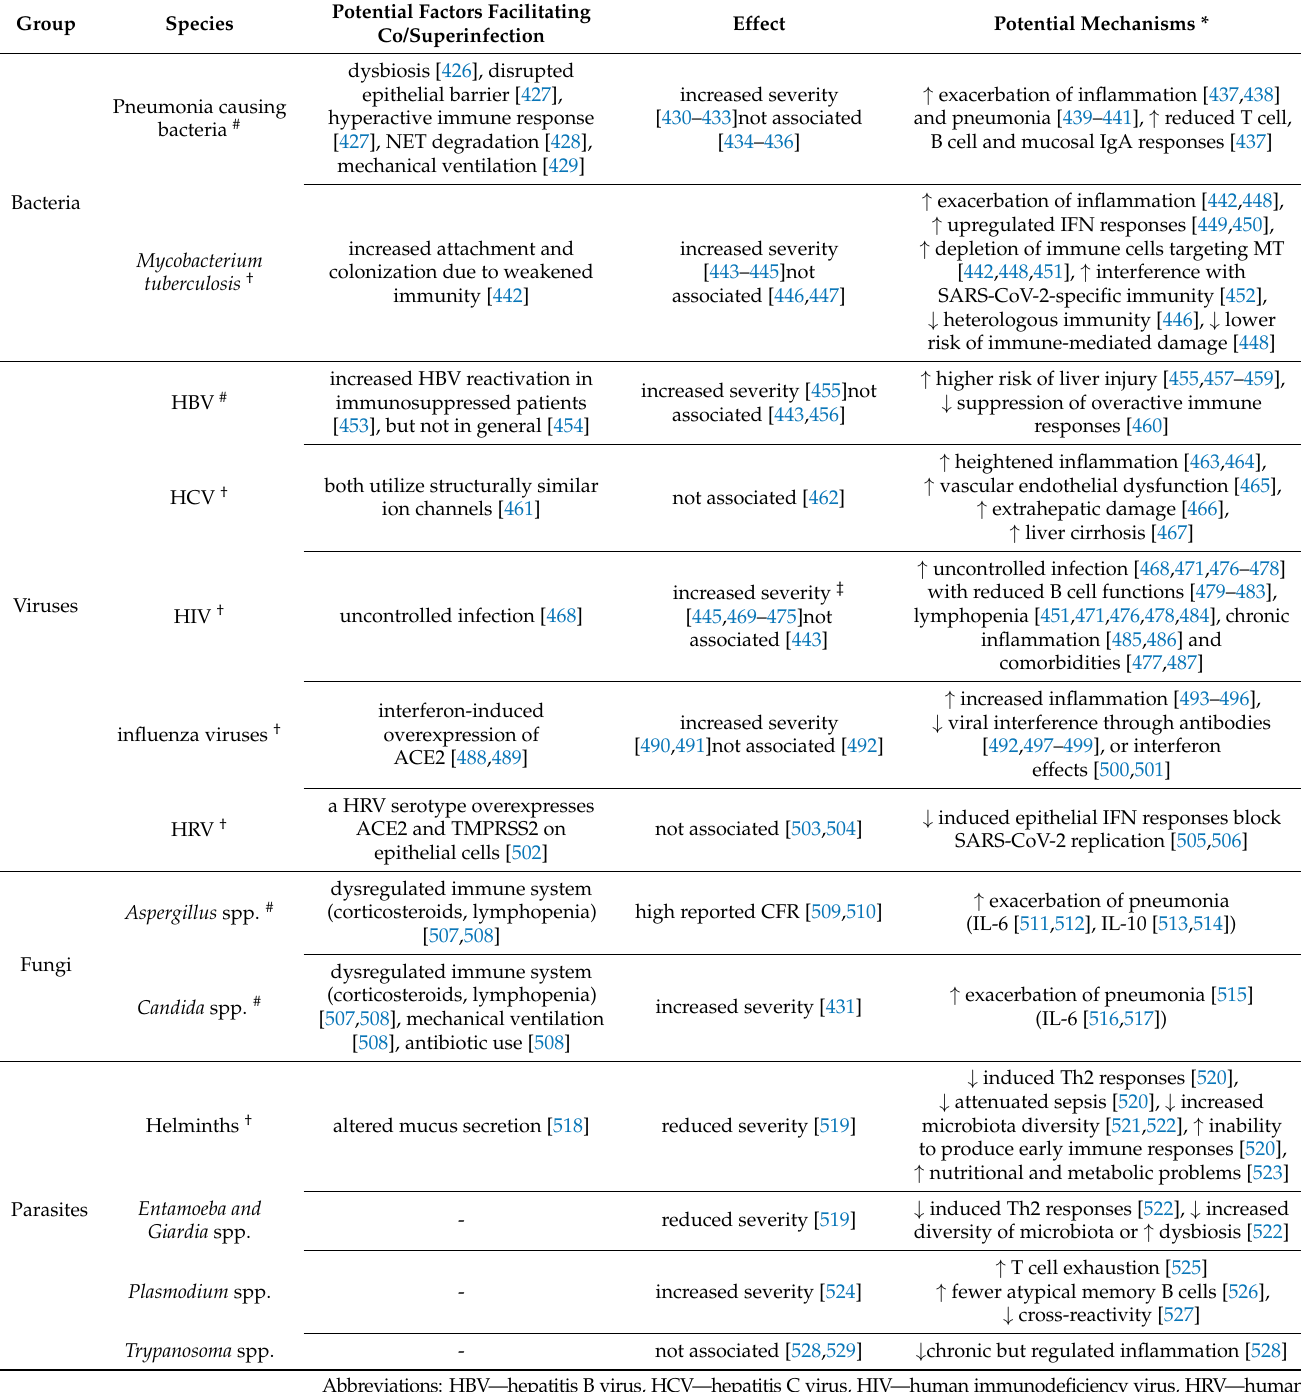
Table 5. Co- and superinfections tested for associations with COVID-19